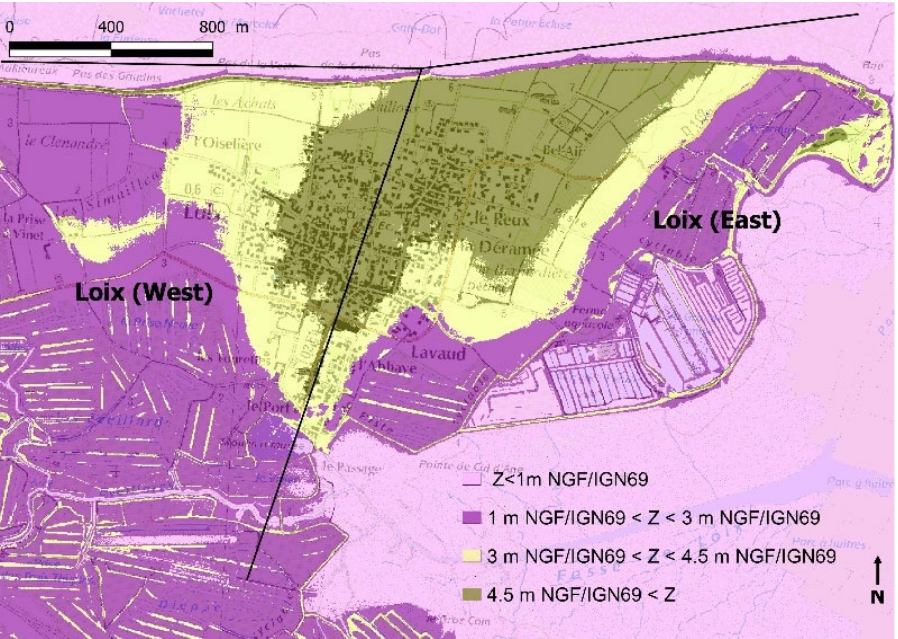
Figure 5. Schematic representation of the Loix protection system. 2.3. “Source–Pathway–Receptor” In addition to the previously explained approaches, flood risk analysis can use the “source–pathway–receptor (SPR)” model [51]. This model represents interactions be ‐ tween the environment and the protection system. It helps identify the links between:  natural phenomena that initiate the event (sources);